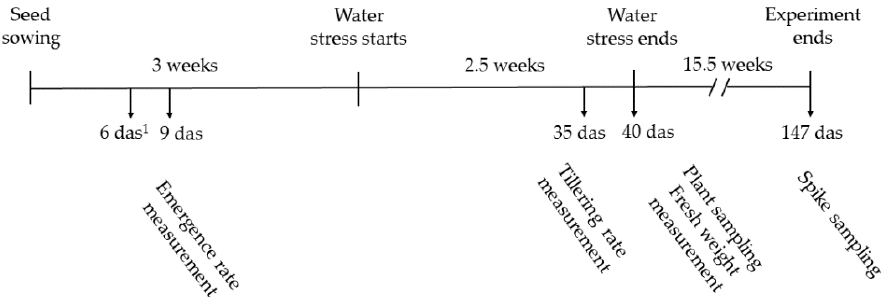
Figure 1. Representation of the running and sampling time points for the wheat- Trichoderma assay performed under greenhouse conditions. 1 das: days after sowing.